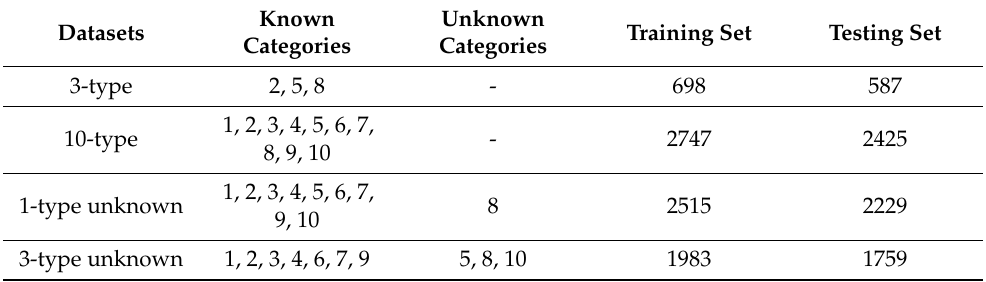
Table 3. Experimental datasets configuration.